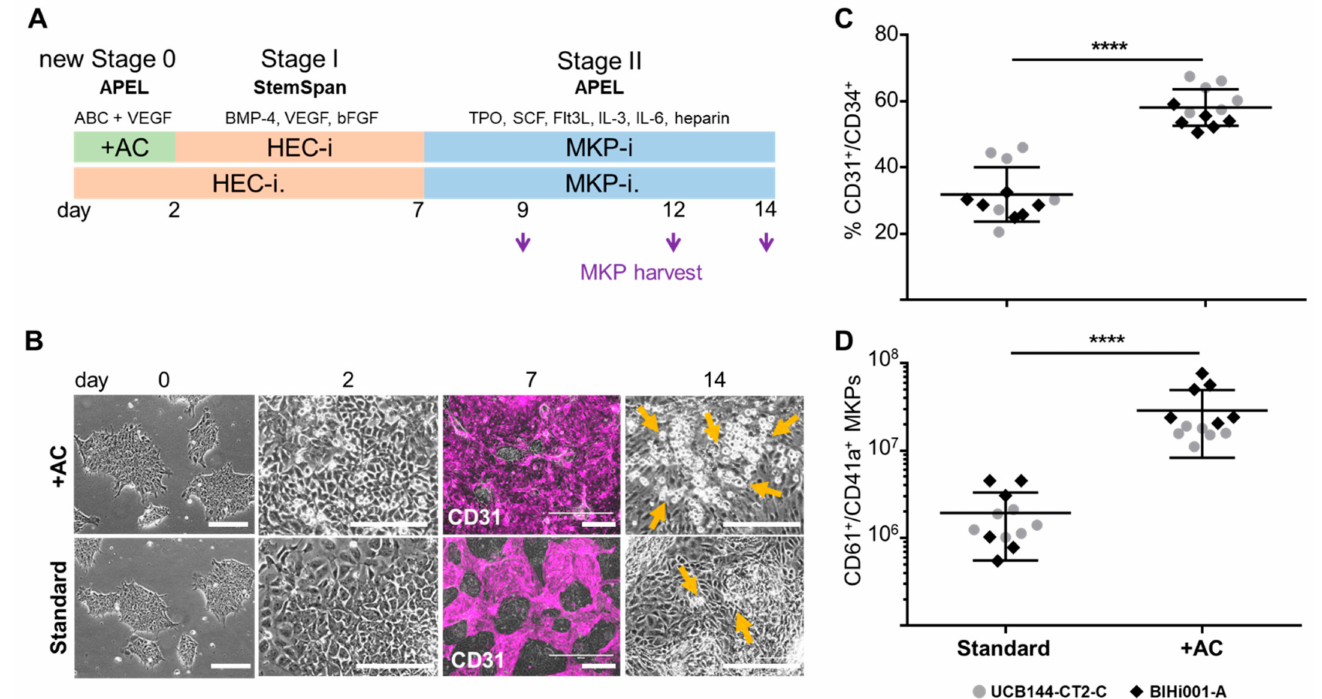
Figure 1. Production of hemogenic endothelial cells (HECs) and megakaryocyte progenitors (MKPs) from hiPSCs. ( A ) Experiment outline of hiPSC differentiation towards MKPs via HECs without (Standard) or with initial two-day (stage 0) induction including activin A and CHIR99021 (+AC) in APEL (Albumin Polyvinylalcohol Essential Lipids) medium containing activin A, bone morphogenetic protein-4 (BMP-4), CHIR99021 (ABC), and vascular endothelial growth factor (VEGF). Regular stage I and stage II media for HEC induction (HEC-i.) and MKP induction (MKP-i.) are composed as indicated (see Table 1). Floating MKPs were harvested on days 9, 12, and 14 as indicated by purple arrows. ( B ) Cell morphology documented on days 0, 2, 7, and 14 during hiPSC to MKP differentiation. Representative pictures from four replicates of clone UCB144-CT2-C are shown. In situ CD31 reporter staining on day 7 highlighting HECs (purple). Depicted reporter staining results corresponding to 66% and 20% CD31 + /CD34 + cells with improved vs. standard conditions, respectively, as analyzed by flow cytometry (Appendix A Figure A1). On day 14, round-shaped floating cells (indicated by orange arrows) were more prominent after initial induction (+AC). Scale bars: 200 µ m. ( C ) CD31 + /CD34 + cells as detected by flow cytometry after improved compared to standard conditions on day 7 ( n = 12; p < 0.0001). ( D ) CD61 + /CD41a + MKPs after induction (+AC) per 1 × 10 6 starting hiPSCs compared to standard conditions ( n = 12; p < 0.0001). Results from hiPSC clones UCB144-CT2-C (grey circles) and BIHi001-A (black diamonds); unpaired t-tests, **** p < 0.0001 ( C , D